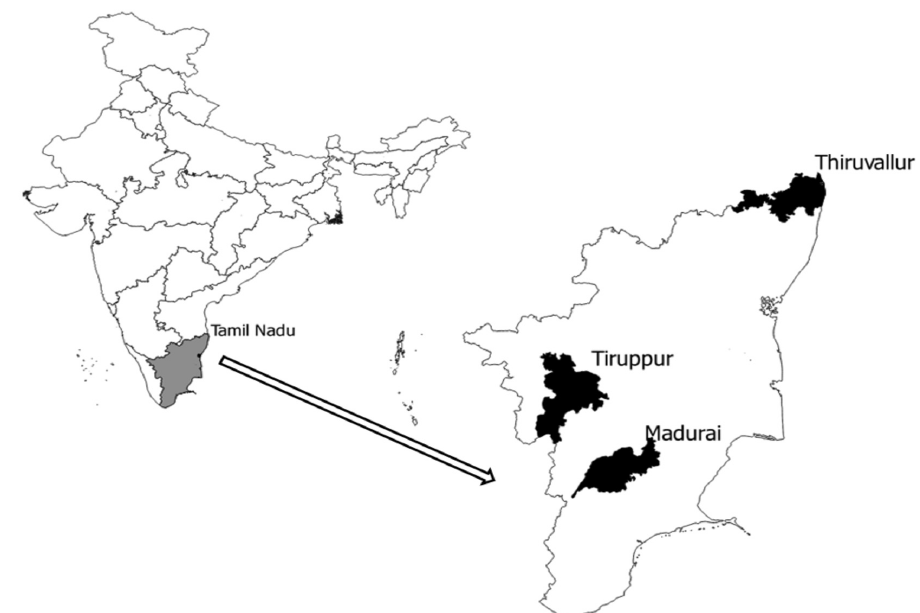
Figure 1. Map of India showing the three study districts in Tamil Nadu,